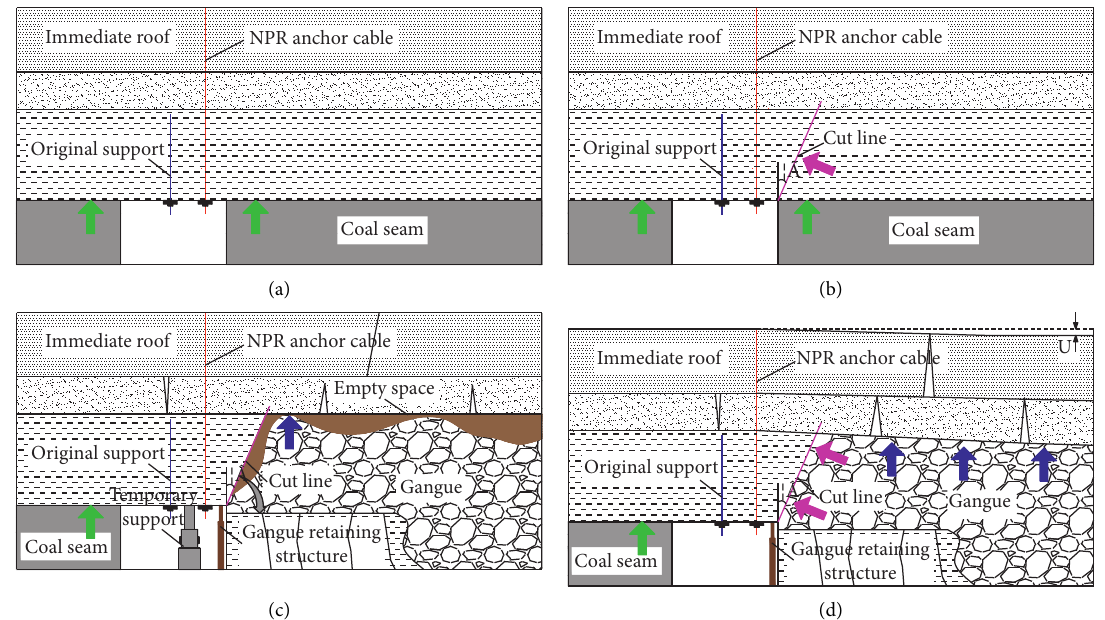
Figure 1: Dynamic structure model of surrounding rock in RCPR GER.